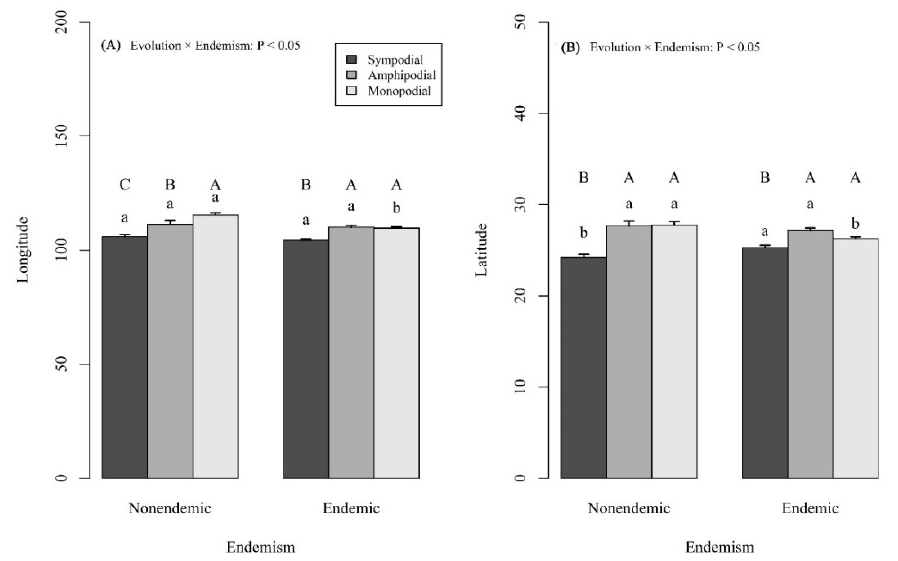
Figure 3. Variations of the longitude and latitude between different endemism and among different rhizome types. Boxes with different letters differ significantly at p < 0.05. The lowercase letters mean the difference between different endemism types. The uppercase letters mean the differences among different rhizome types. “ × ” means the interaction between two